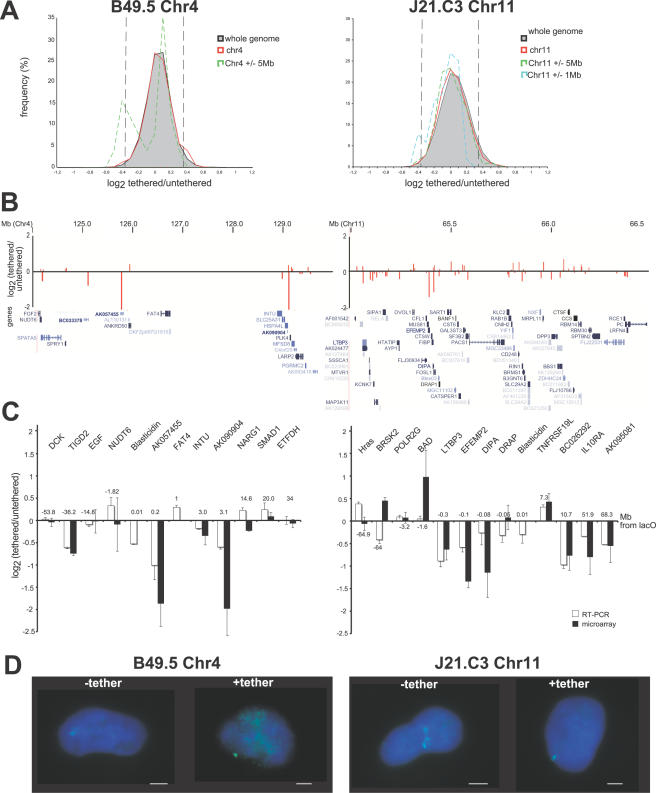
Gene Expression Changes in lacO-Tagged Cell Lines.(A) Frequency histograms of log2 tethered/untethered (i.e +/−lacI-lap2β) cDNA ratios for a moving average of 5 genes in cell lines B49.5 (left) and J21.C3 (right). Data for the whole genome (shaded in grey) are compared to the data from the whole of the respective tethered chromosome (red line) or for windows of +/−5 and 1 Mb (green and blue dashed lines respectively) centered around the site of lacO integration in each cell line. Dashed lines indicate the 99% confidence limits set from self-self hybridisations. (B) Mean log2 tethered/untethered (i.e +/−lacI-lap2β) cDNA ratios for genes in the 6 Mb near the lacO site on chromosome 4 in B49.5 cells (left) or the 1.5 Mb region close to lacO on chromosome 11 in J21.C3 cells (right). Mapping data and gene positions are relative to the May 2004 assembly of the human genome in the UCSC browser. (C) qRT-PCR analysis of endogenous genes on chromosome 4 (left) or chromosome11 (right) as well as the blasticidin gene that is in cis with the lacO sites. Graphs show the mean (+/−s.e.m) log2 tethered/untethered (i.e +/−lacI-lap2β) ratios from independent analyses, normalised to β-actin (white bars). Black bars indicate the log2 ratios obtained from the microarray analysis. Values along the x axis indicate estimated distance from lacO integration site in Mb (+values are telomeric of the integration site, −ve values are centromeric). (D) RNA FISH for blasticidin transcript (green) on B49.5 and J21.C3 untethered cells and the corresponding cell lines expressing lacI-lap2β (tethered). Scale bars = 2 µm.